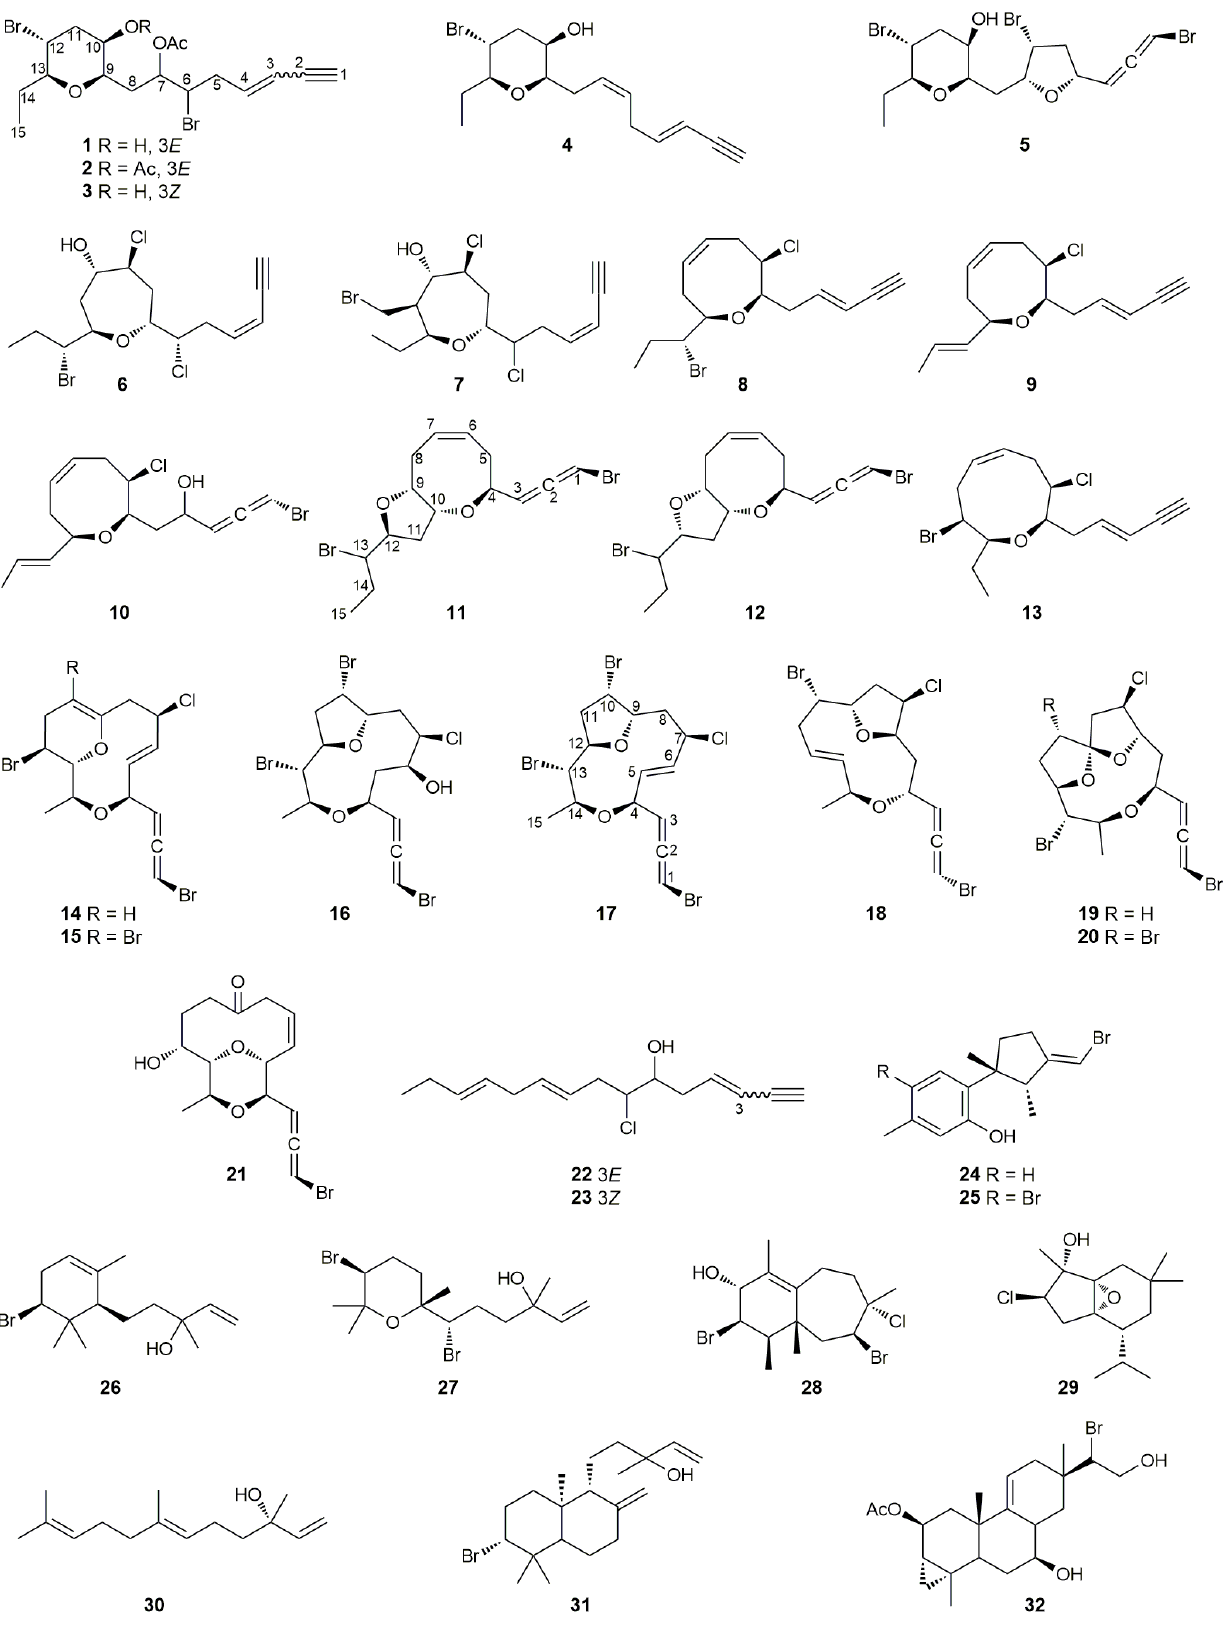
Figure 1. Chemical structures of compounds 1 – 32 isolated from the red algae Laurencia microcladia ( 1 – 7 , 11 – 12 , 24 – 27 , and 29 – 32 ) and Laurencia obtusa ( 7 – 10 , 13 – 25 , and 28